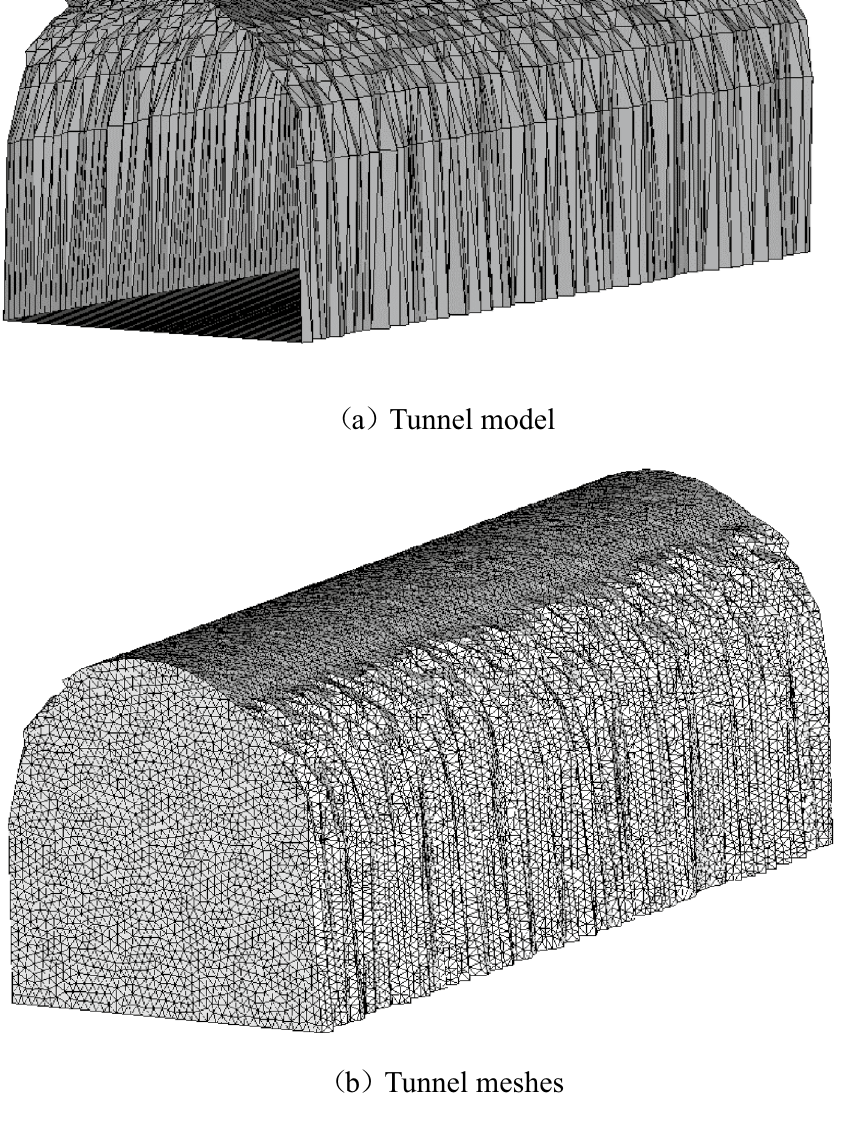
Figure 8. Numerical boundary model.